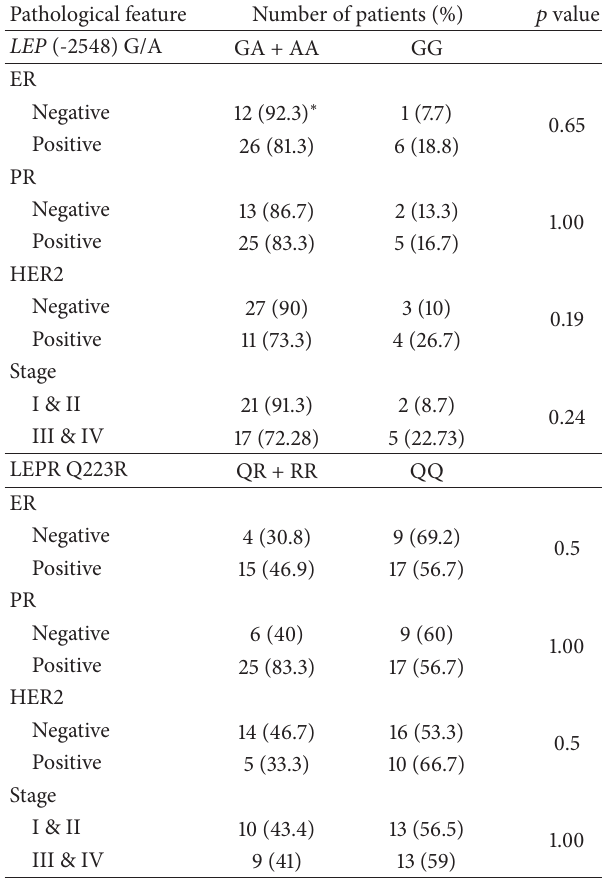
Numbers in parentheses represent the